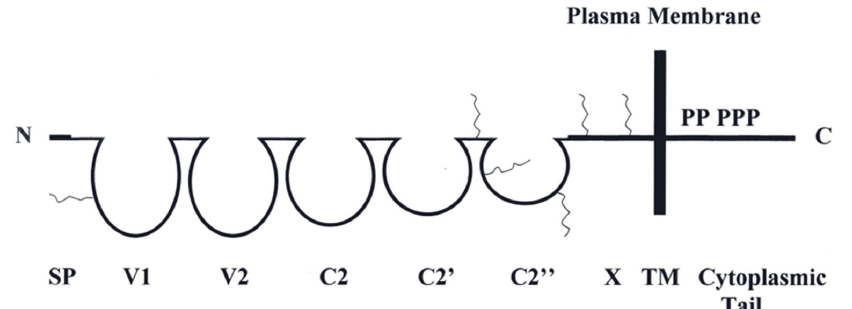
Figure 1. The protein structure of huMETCAM. In the extracellular part of the protein: SP stands for the signal peptide sequence at the N ‐ terminus; five domains, V1, V2, C2, C2 ′ , and C2 ″ , stand for five immunoglobulin ‐ like domains (which are held by a disulfide bond); and one domain, X, stands for another domain (without a disulfide bond). TM stands for the transmembrane domain. P stands for the five possible phosphorylation sequences (one for PKA, three for PKC, and one for CK2) in the cytoplasmic tail of the protein. The wiggly lines indicate the six conserved N ‐ glycosylation sites located in the V1 domain, the region between the domains of C2 ′ and C2 ″ , the domain of C2 ″ , and the X domain.